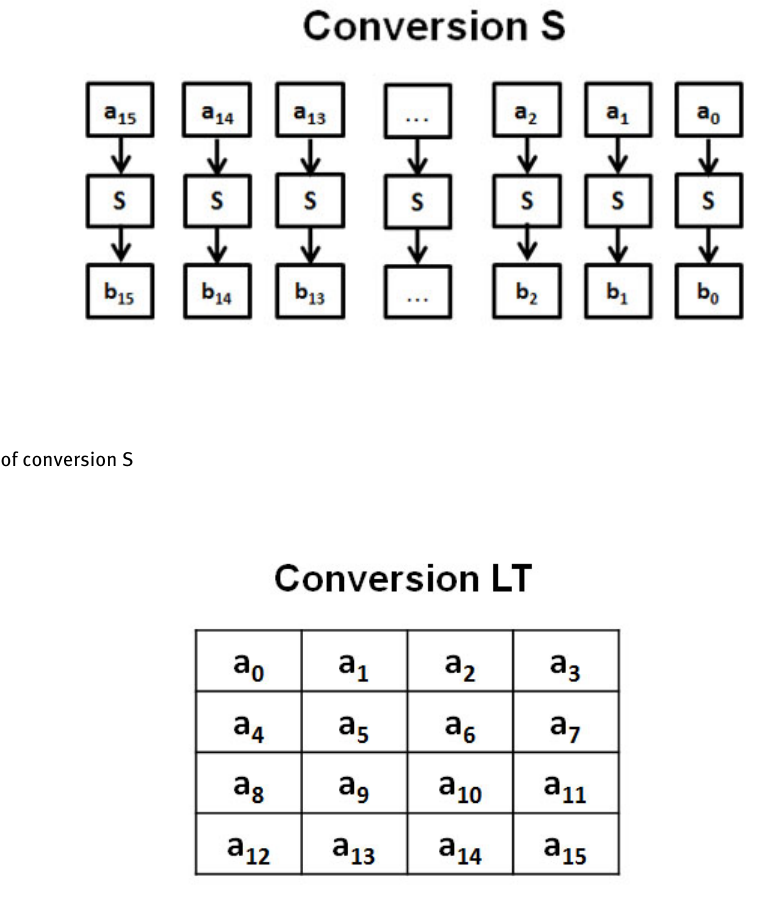
Figure 3: The location of the bytes in LT